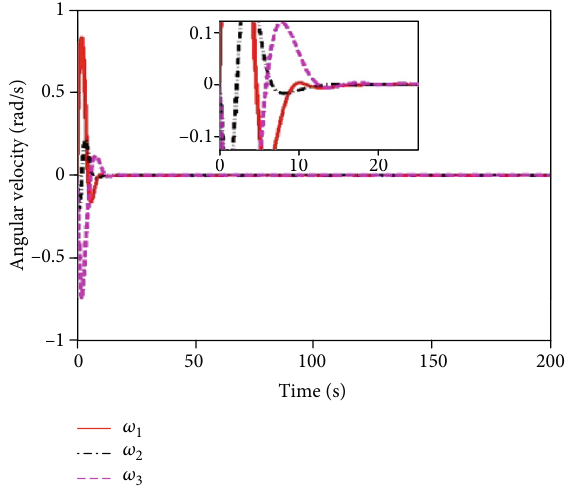
Figure 17: Time histories of fi lter vector in Case 3 when k ð 0 Þ = 0 : 5